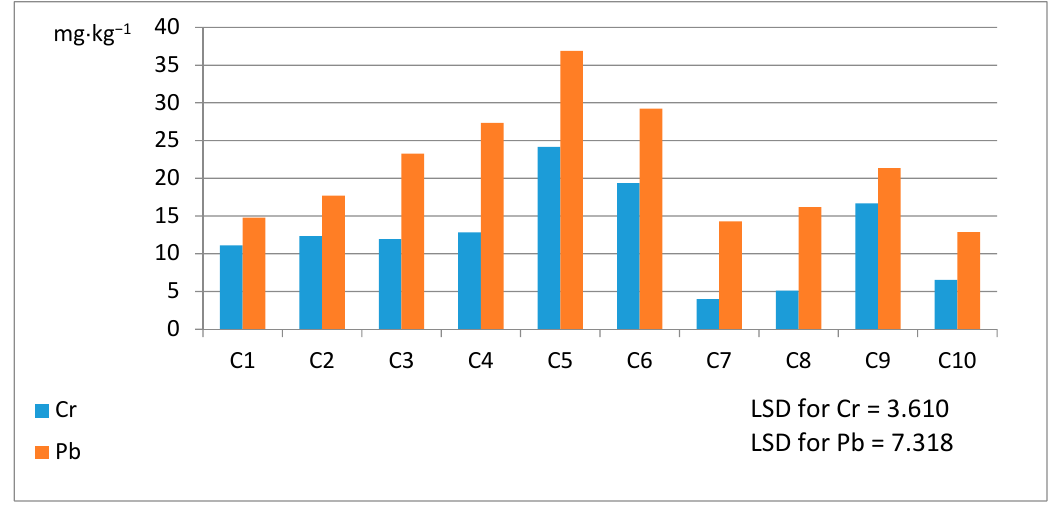
Figure 5. Heavy metal contents in analysed composts.